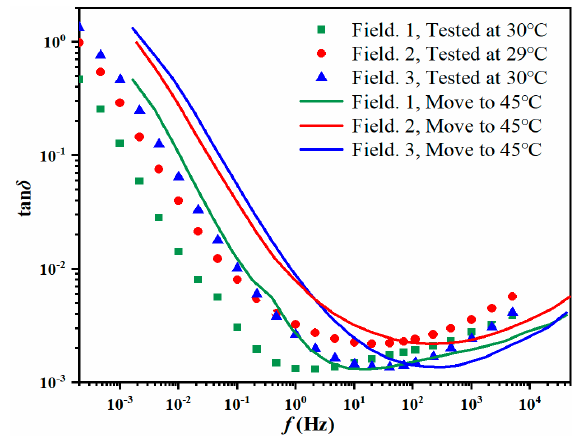
Figure 9. Temperature correction of field data.